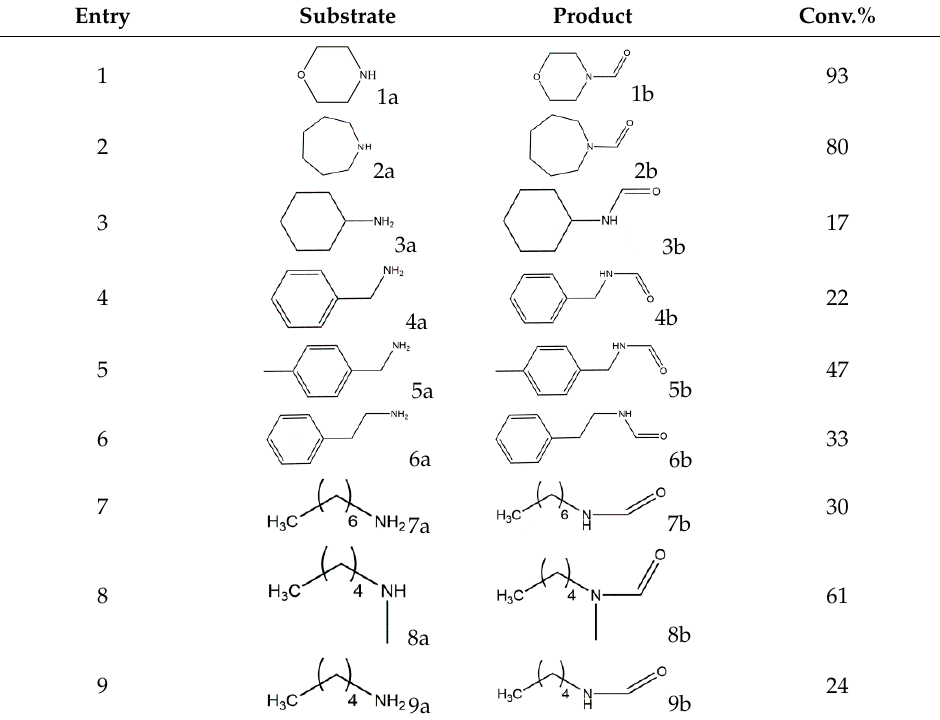
Conditions: morpholine, 1 mmol; Pd, 2.3 mol% based on morpholine (Pd loading is 2.5 wt%); K 3 PO 4 , 0.33 mmol;